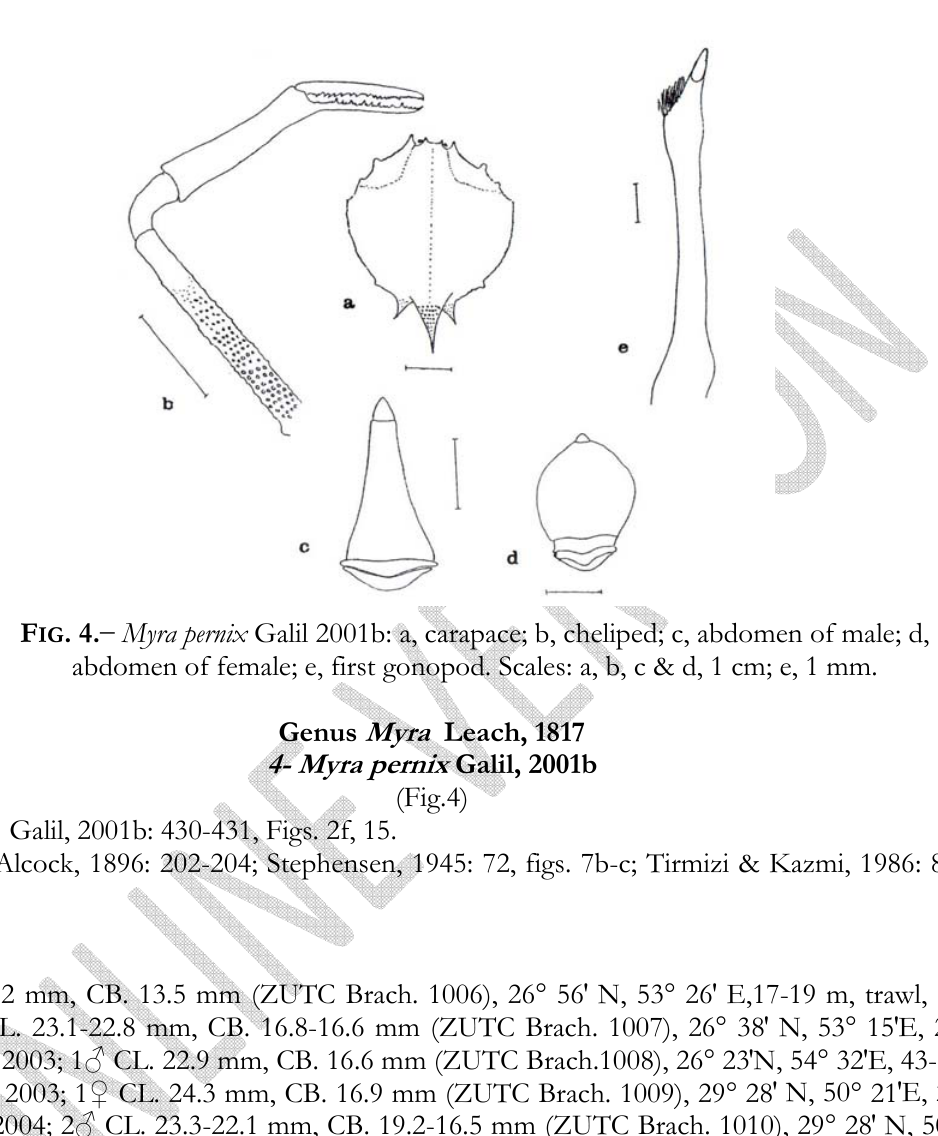
Carapace (Fig. 4-a) subcircular, three large granulate spines in the posterior margin of carapace,